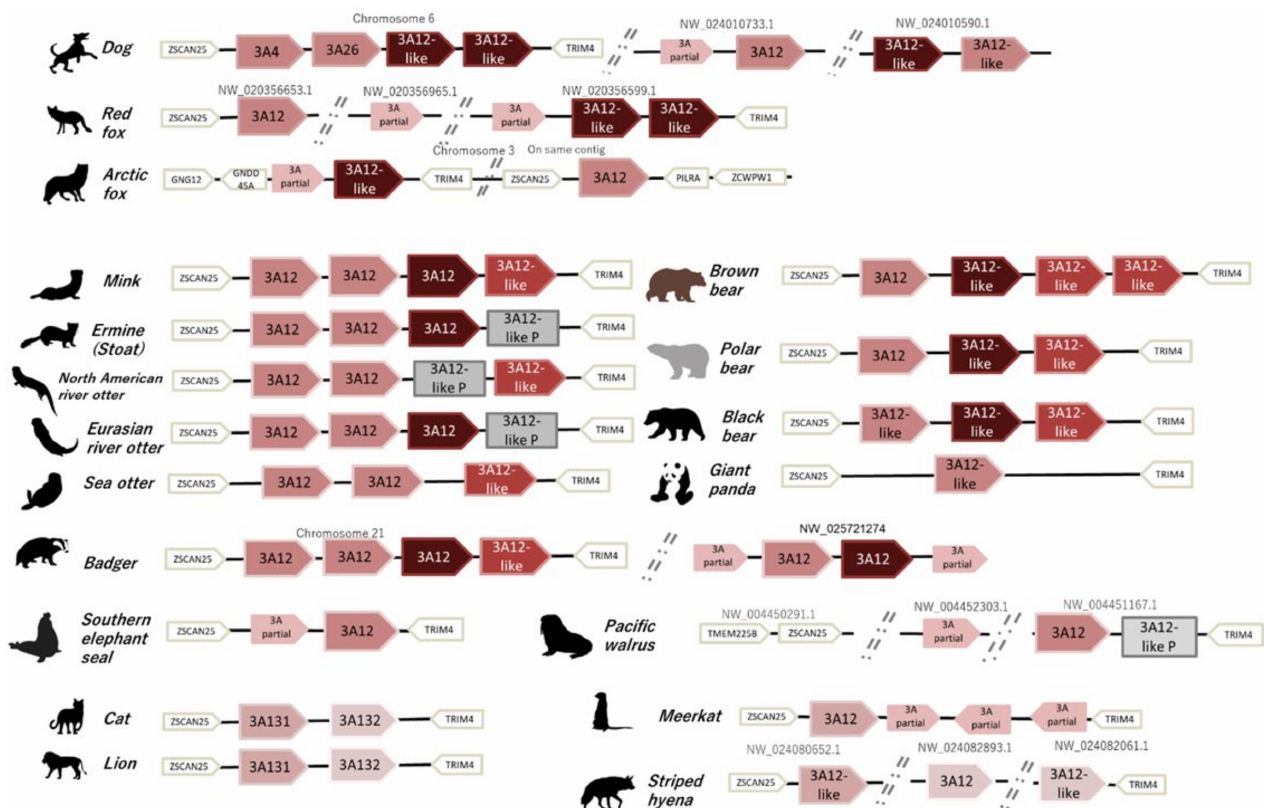
Figure 3. Synteny of the CYP3A cluster among Carnivora. Representative species of each family were selected. Phylogenetic-analysis-supported classifications were applied to each isoform and colored based on each clade. Caniformia CYP3As in clade 1, clade 2, and clade 3, and CYP3A131s and CYP3A132s in Felidae, are all differently colored. Letters on each locus show coding contigs if separately coded. Pseudogenes are shown as gray